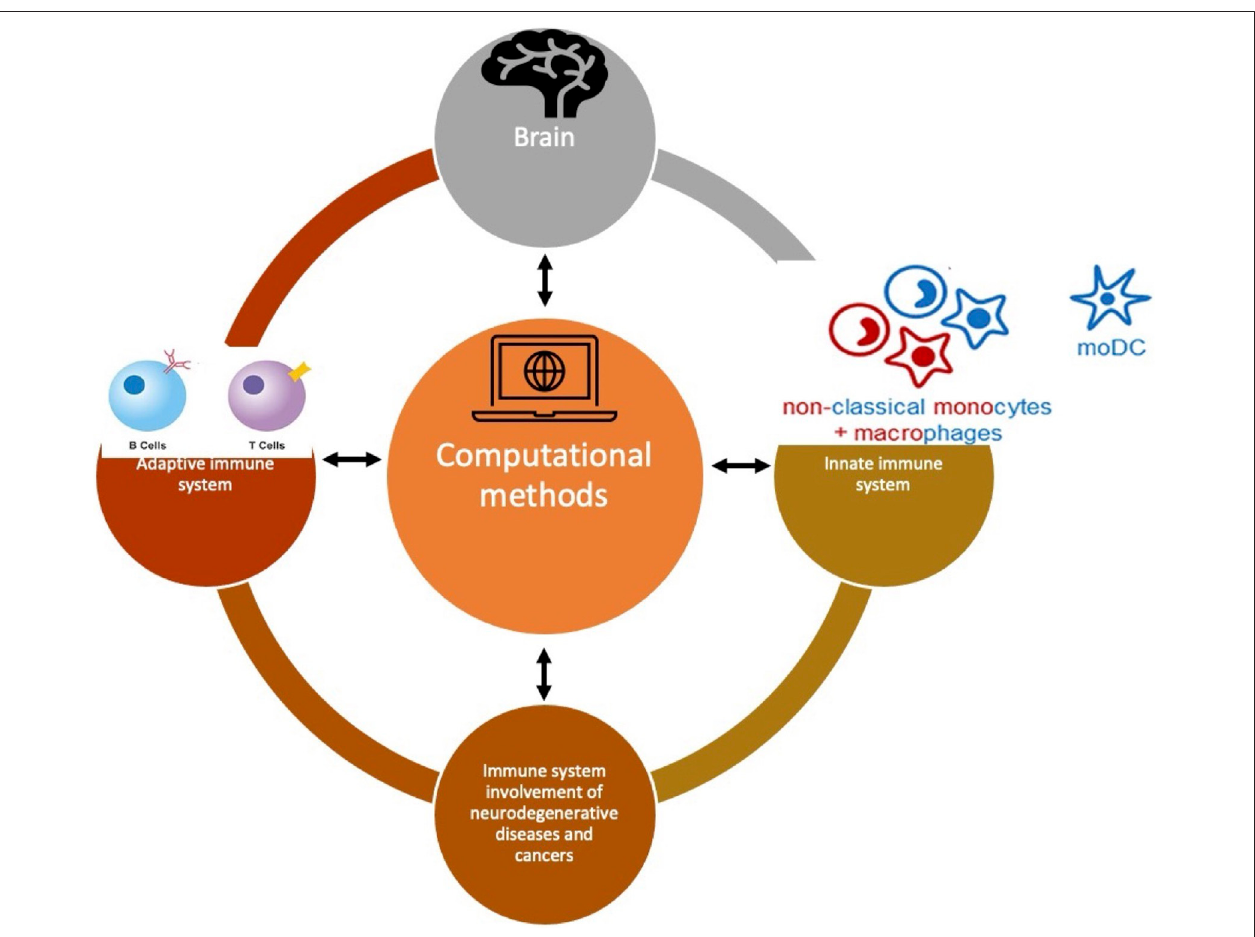
FIGURE 1 | A conceptual fi gure showing that neuroimmunological diseases are very diverse but connected through common bioinformatics or computational methods to understand their pattern. The different immune cells are illustrated here whereas the brain is shown in general as an organ. All these cells and the organ are connected through computational